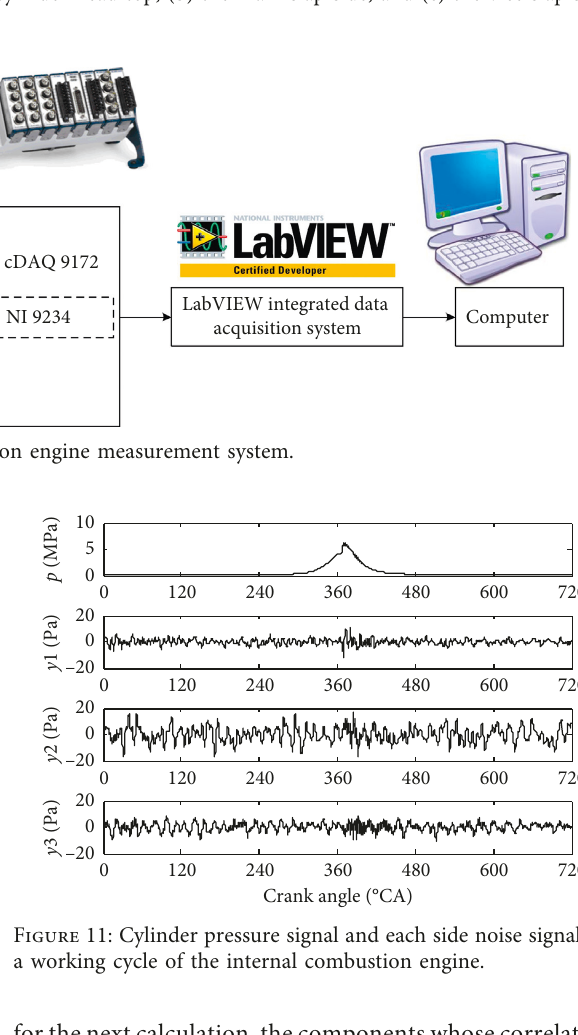
Figure 9: Specific location of noise measurement points. At (a) the cylinder head top, (b) the main slap side, and (c) the vice slap side.